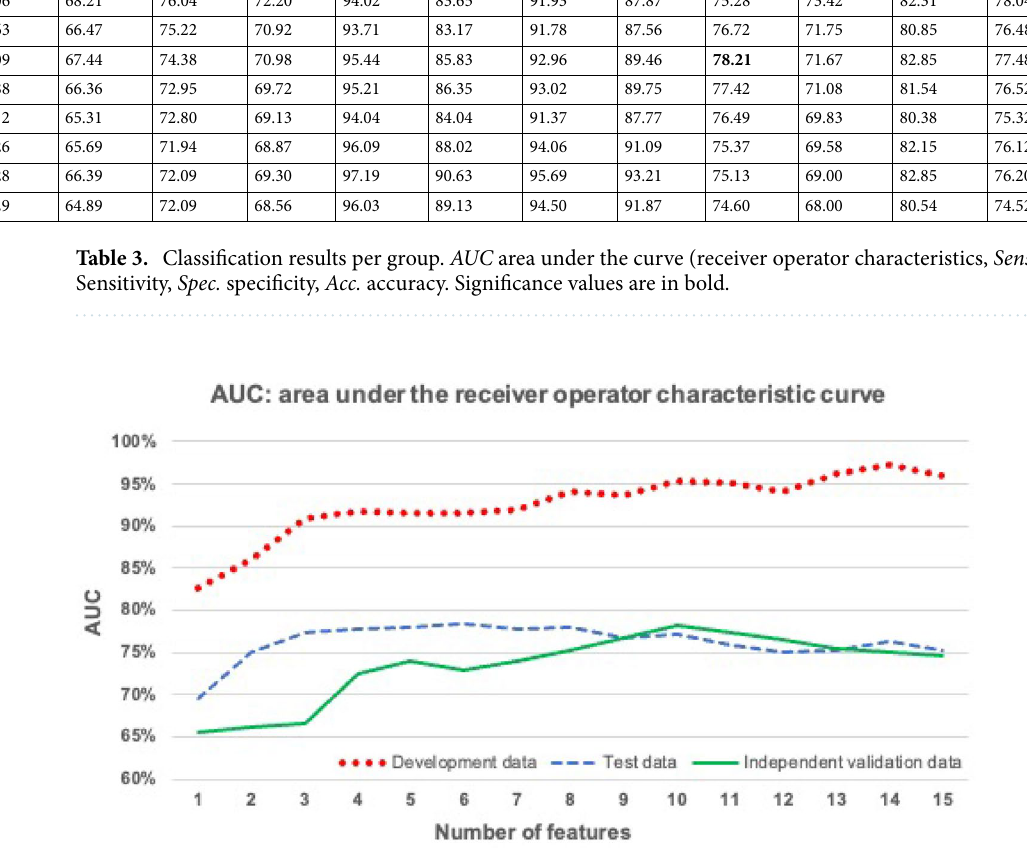
Figure 1. Mean area under the curve (AUCs) of 100 cycles for the GBM models with ascending number of Radiomics